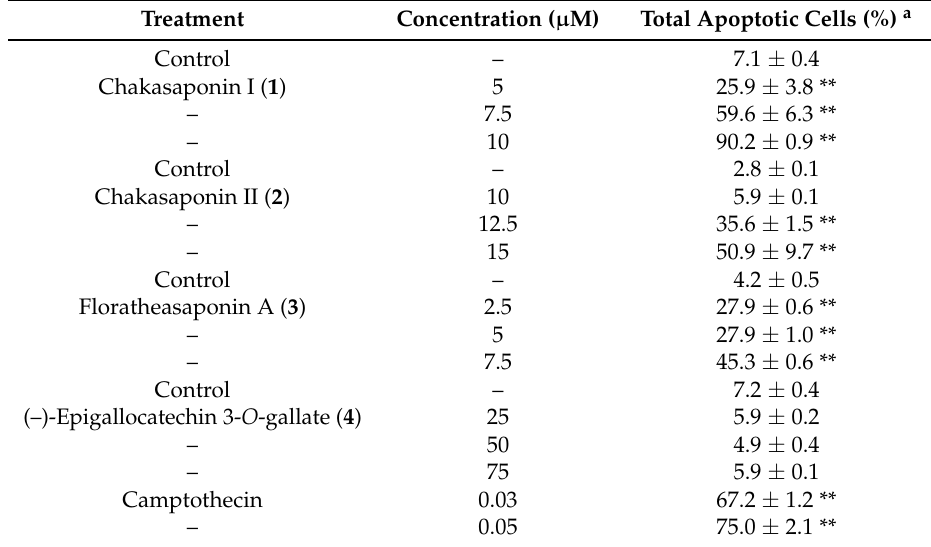
Table 4. Effects of 1 – 4 and camptothecin on caspase-3/7 in HSC-2 cells.